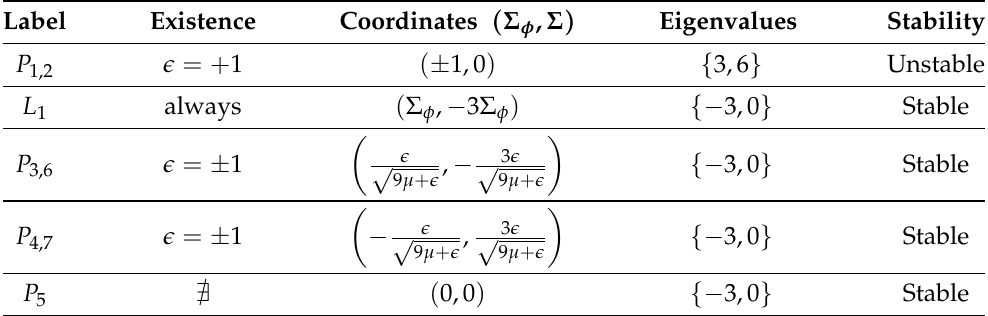
Table 1. Equilibrium points of System (68)–(69) for (cid:101) = + 1 with their eigenvalues and stability. P 5 is a sink, but does not satisfy the condition